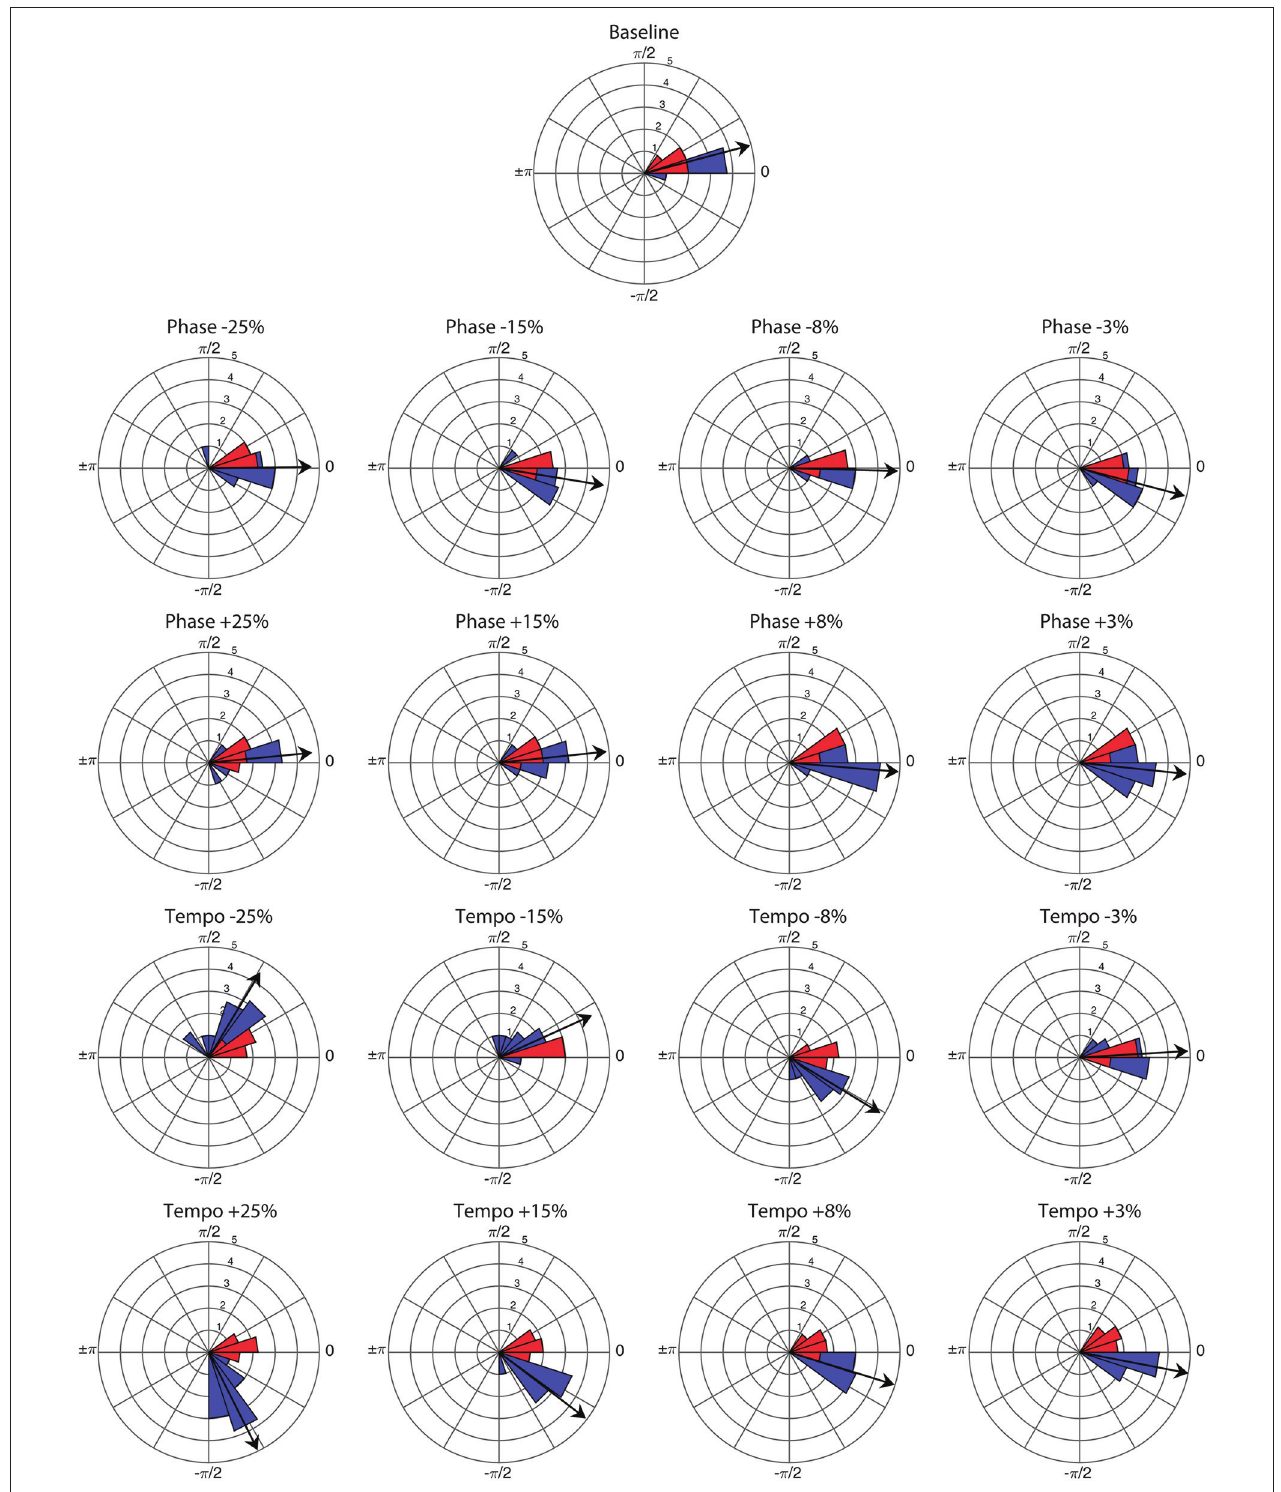
FIGURE 1 | Angular distribution of phase angles for the first presentation of each perturbation condition ( n = 16 ) and baseline trial ( n = 1 ) at a base tempo of 85 bpm. Red wedges show 10 bobs prior to the perturbation and blue wedges show 25 bobs following. The radius of each wedge represents the square root of the number of bobs in that wedge, so that the area of each wedge is equal to the number of bobs. The arrow indicates the mean vector of the post-perturbation bobs, with length normalized to the outer radius of the plot. Note that angles > 0 represent bobs trailing the stimulus beat, and angles < 0 represent bobs leading the stimulus